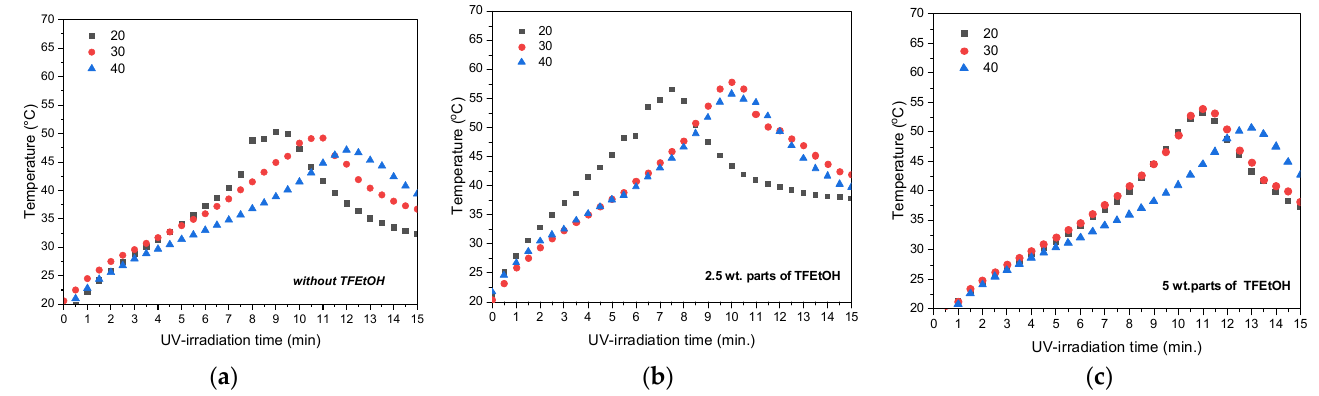
Figure 4. Temperature during the UV-phototelomerization process (20, 30, or 40 wt. parts of LMA and 0 ( a ), 2.5 ( b ), or 5 wt. parts of the fluorotelogen ( c ). The presented thermographs confirm that the higher lauryl methacrylate concen-